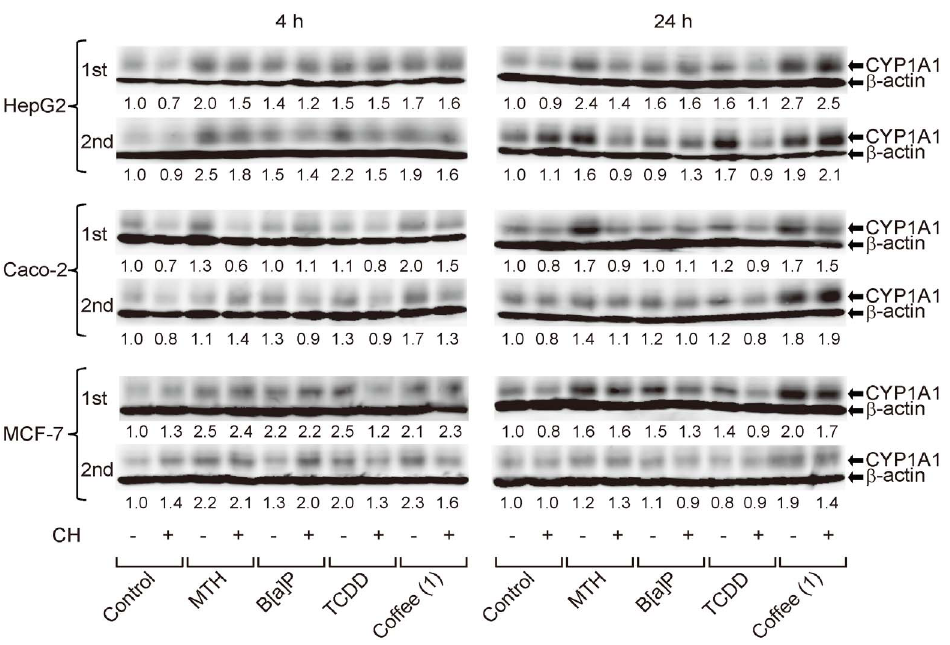
Figure 5. Induction of CYP1A1 protein by coffee. HepG2, Caco-2, and MCF-7 cells were cultured for 4 or 24 h in AHS with each sample added as in Fig. 3, except that TCDD was added only at 10 2 6 M. Because CYP1A1 protein was undetectable in cells incubated in PBS for either 4 or 24 h, only the results from cells placed in AHS are shown. In order to clearly visualize the CYP1A1 signals (56 kDa), the immunoblots in which the simultaneously detected b -actin bands (43 kDa) were overexposed are presented. Two experiments (‘‘1 st ’’ and ‘‘2 nd ’’) were performed independently. The relative band intensities (CYP1A1/ b -actin), which were determined by defining the value observed in control cells as 1.0, are shown below each immunoblot.